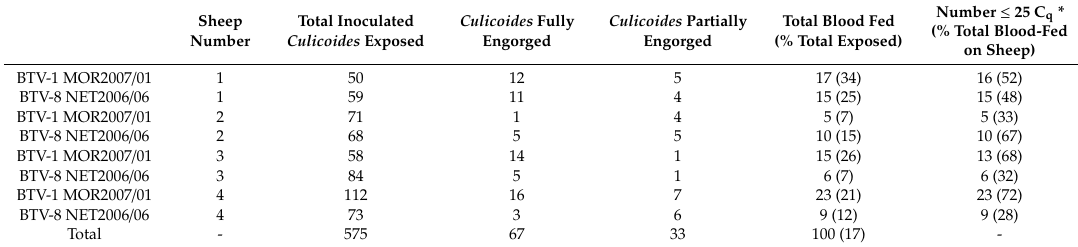
Table 1. Number of intrathoracically (IT) inoculated Culicoides sonorensis blood fed on sheep. Each C. sonorensis was inoculated with either a bluetongue virus serotype 1 (BTV-1) or BTV-8 strain and then incubated in pill boxes at 25 ◦ C for five days prior to feeding on sheep. Number ≤ 25 C q * Culicoides Fully Culicoides Partially Sheep Total Inoculated Total Blood Fed (% Total Blood-Fed Culicoides Exposed Number Engorged Engorged (% Total Exposed) on Sheep) BTV-1 MOR2007 / 01 50